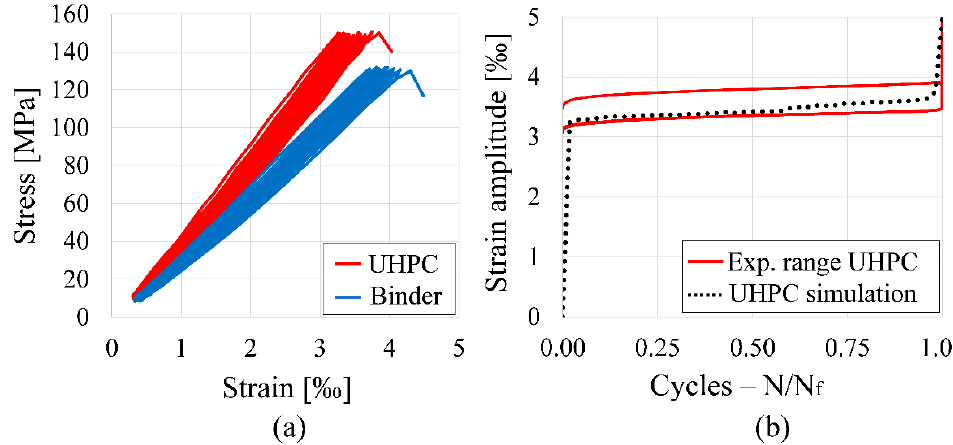
Figure 10. Macroscopic fatigue simulation results of UHPC using the proposed bond formulation with 𝛿 n ,𝛿 s = 6 : ( a ) Hysteresis loops obtained from fatigue simulations for UHPC and binder; ( b ) Comparison of mean S-N curve from UHPC simulations with experimental range.